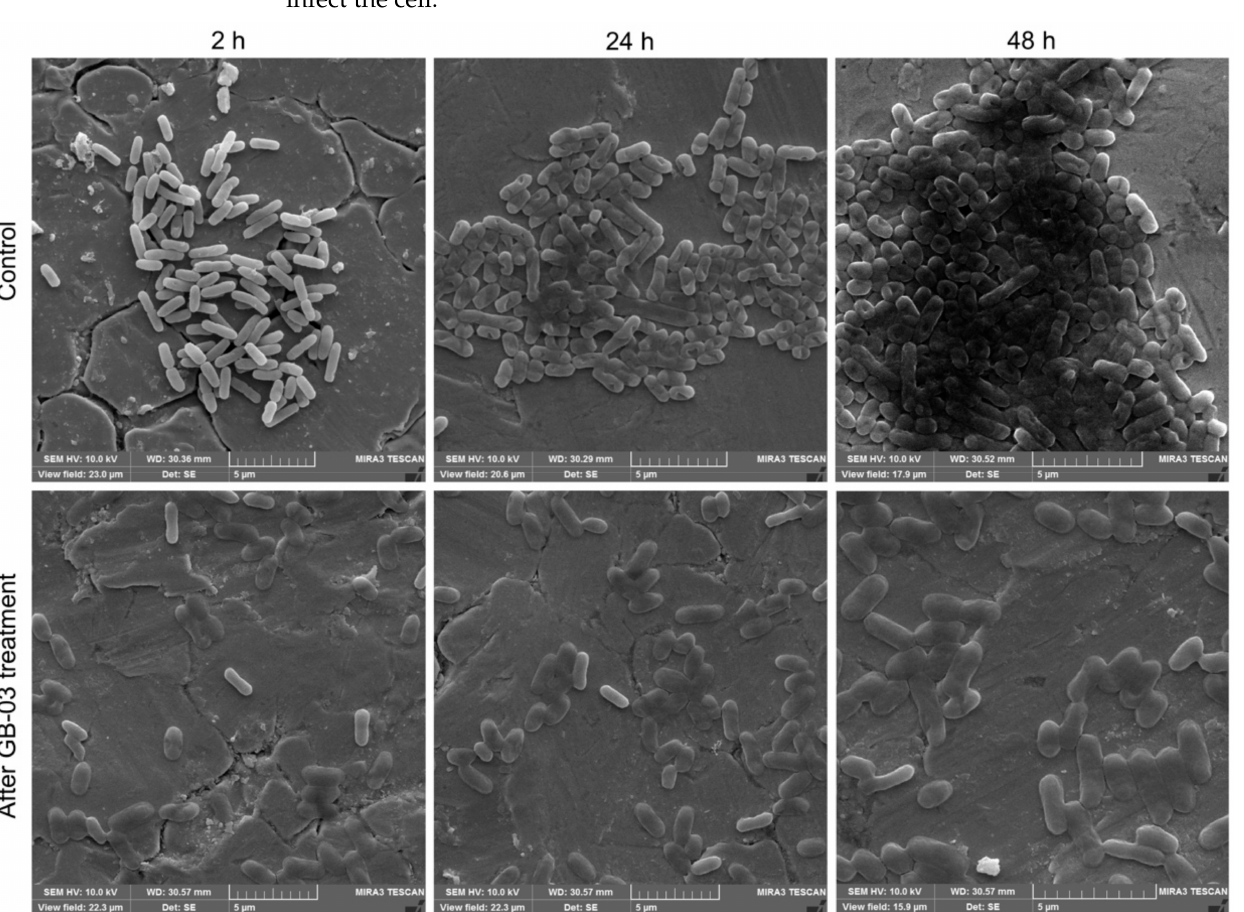
Figure 4. SEM micrographs of MGA-EC-25 biofilms developed on SS coupons at 2, 24, and 48 h with no treatment and after GB-03 exposure at 10 9 PFU/mL for 1